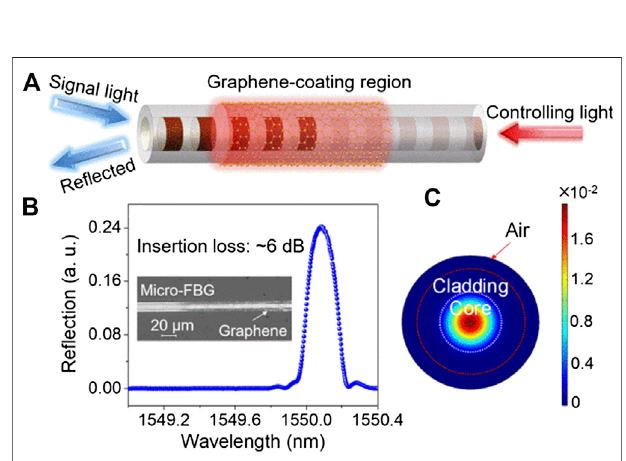
FIGURE 14 | (A) Experimental schematic of the fabricated GCMFBG and (B) its re fl ection spectrum; (C) circular symmetrical energy distribution of the controlling. Copyright 2019, Optical Society of